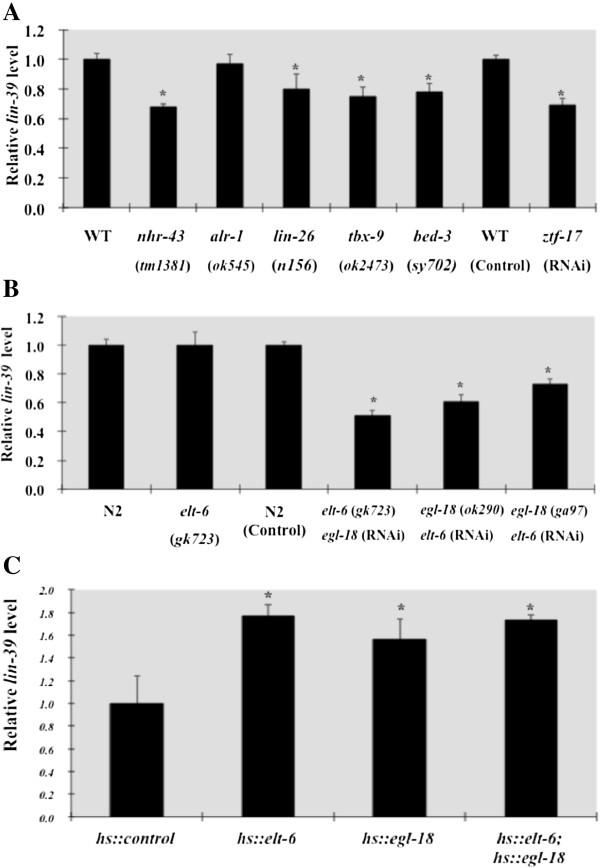
Regulation of lin-39 levels by transcription factors in vivo (qRT-PCR). A) Decrease in lin-39 transcript levels in nhr-43, lin-26, tbx-9, bed-3 mutant and ztf-17(RNAi) animals. B) Decrease in lin-39 transcript levels when activity of both elt-6 and egl-18 is reduced. C) Increase in lin-39 transcript levels when either elt-6 or egl-18 was overexpressed from the heat shock promoter. All analyses were done on L3 stage animals. The mean values for each genotype were obtained from at least two independent experiments and normalized to the housekeeping gene, gpd-2, as internal standard. The data was analyzed with unpaired t-test compared to the appropriate control. ‘*’ indicates P-value < 0.05.